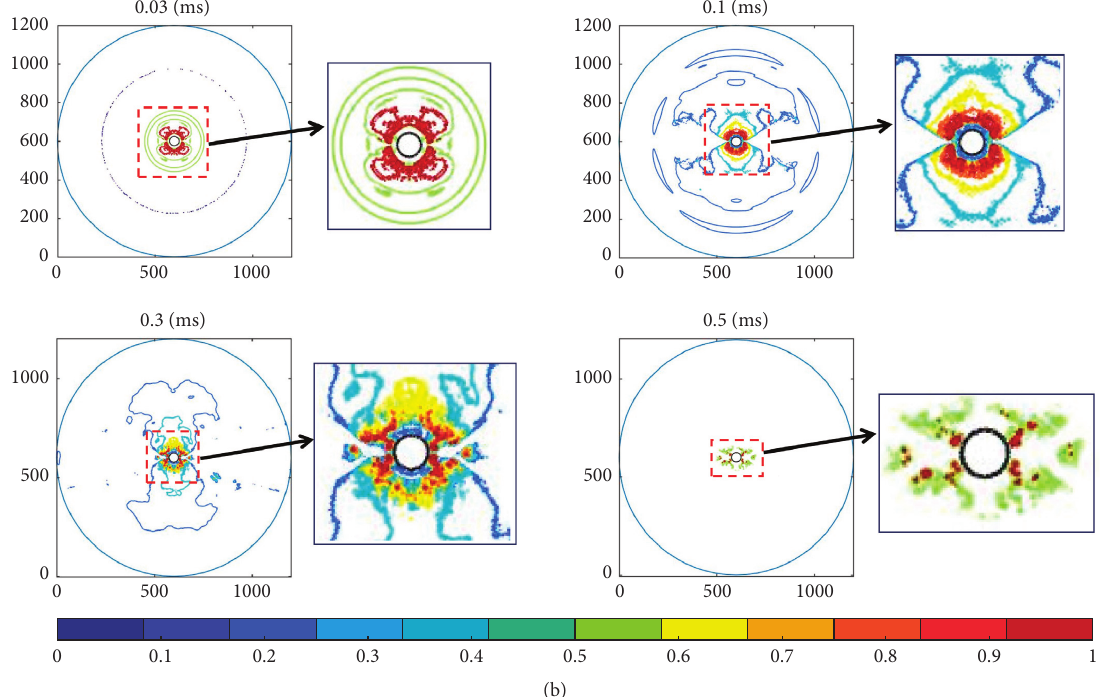
Figure 10: Damage evaluation and effective stress evaluation for 60 ° shaped energy angle blasting. (a) The development process of 60 ° shaped energy angle blasting damage. (b) The development process of equivalent stress of 60 ° shaped energy angle